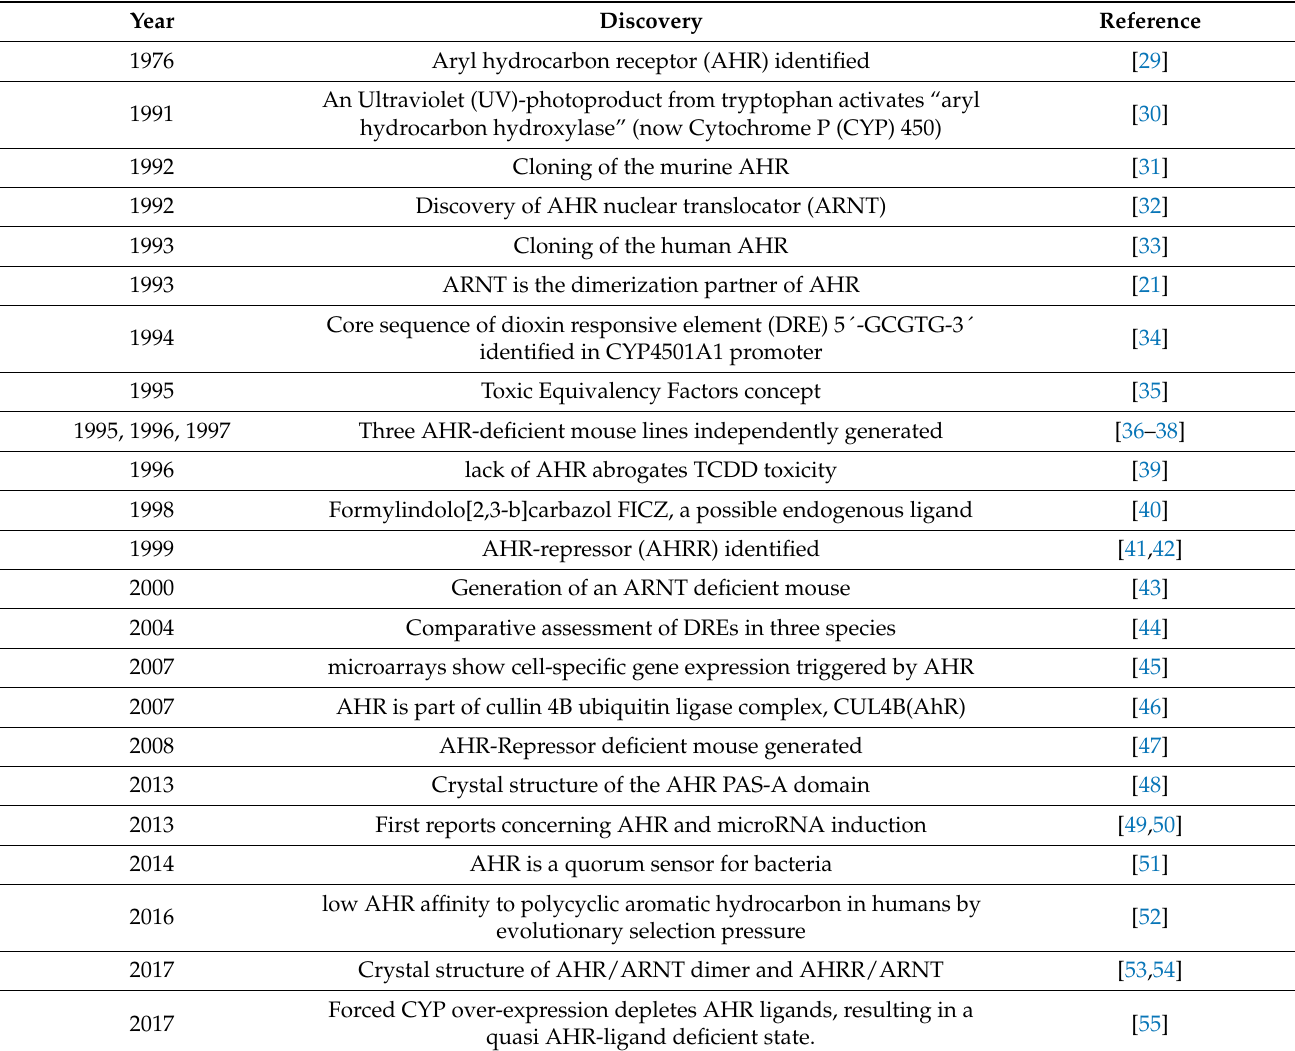
Table 1. Major Milestones of Discovery related to aryl hydrocarbon receptor (AHR) signaling: biochemistry, genetics, and function a